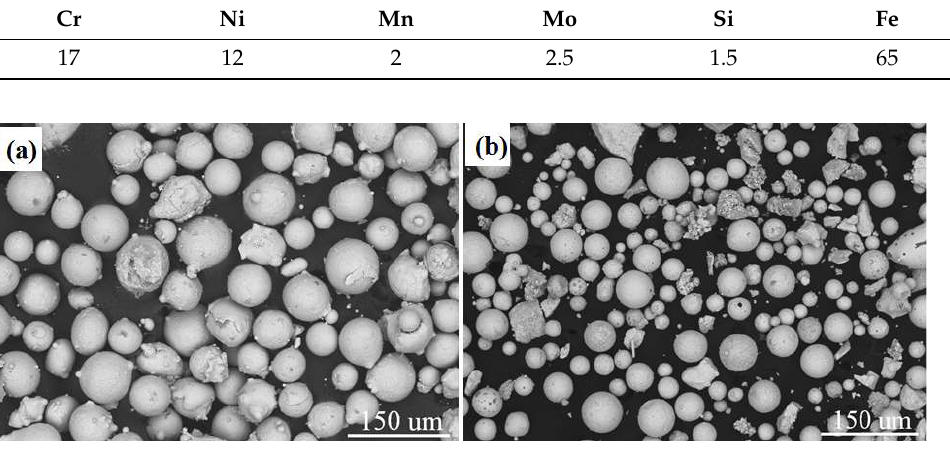
Figure 1. SEM morphology: ( a ) AlCoCrFeNi HEA powders; ( b ) spherical WC